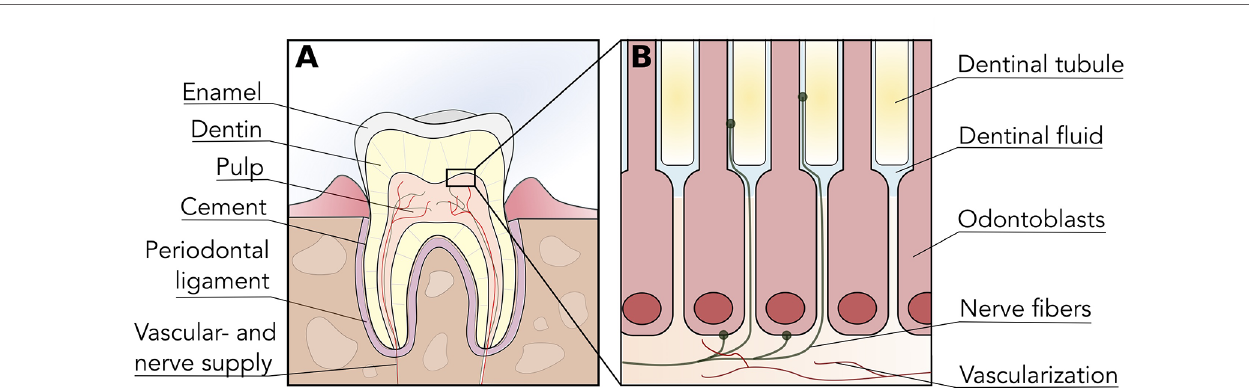
FIGURE 1 | Tooth and dental pulp anatomy. (A) Diagrammatic representation of a tooth cross-section illustrating the organization of enamel, dentin, cement and dental pulp within the tooth structure. The dental pulp is vascularized and innervated through the root apex, which provides nociception via afferent trigeminal nerves. (B) The odontoblast layer is located in the interphase between dentin and dental pulp, with prolongations extending into dentin via dentinal tubules. Sensory nerve fibers penetrate the odontoblast layer and enter the initial portion of dentinal tubules, thus permeability or alterations in dentin can trigger